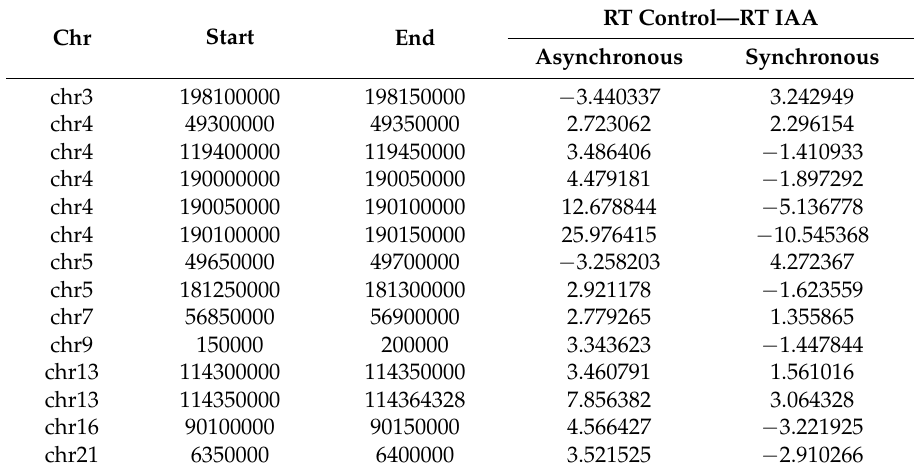
Figure 3. Acute loss of cohesin in S phase does not perturb patterns of replication foci. ( A ) Replication foci patterns were assayed using BrdU IF in asynchronous cells after auxin or control treatment. ( B ) Number of cells in each S phase stage were counted for two biological repeats of auxin-treated and untreated samples. Table 1. Genomic loci showing significant difference in both asynchronous and synchronized